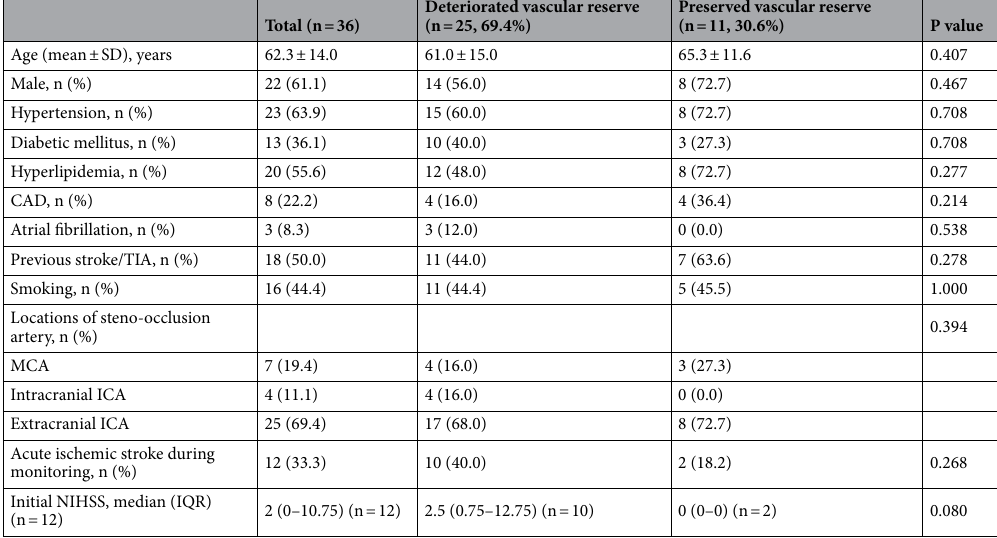
Table 1. Clinical characteristics of study population. SD standard deviation; CAD coronary artery disease; TIA transient ischemic attack; MCA middle cerebral artery; ICA internal carotid artery; NIHSS National Institute of Health Stroke Scale; IQR interquartile